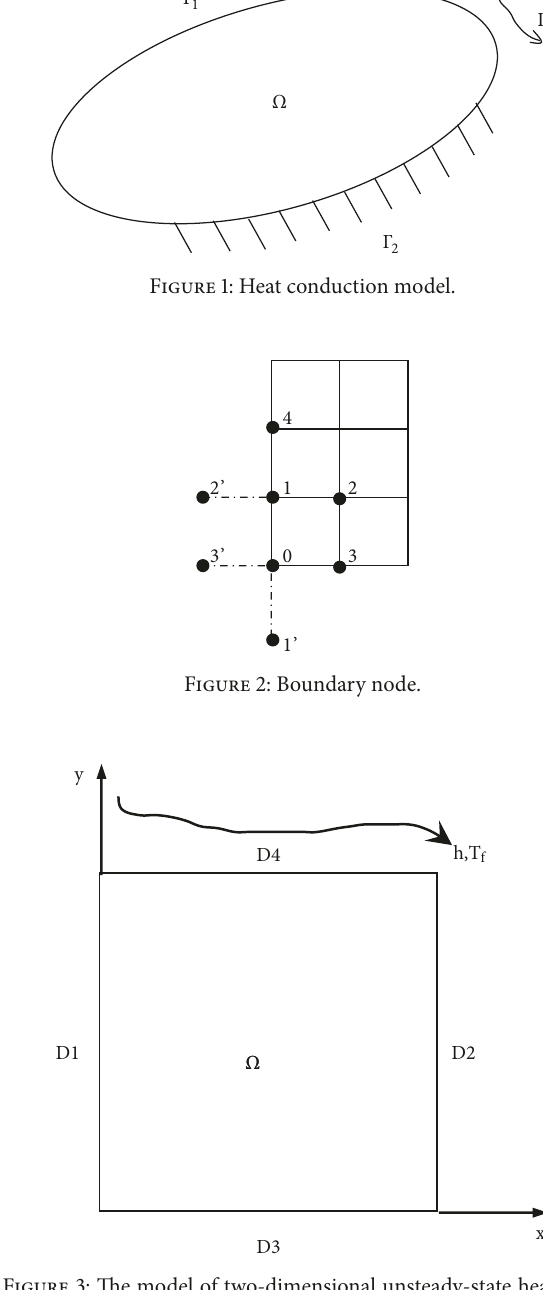
Figure 3: The model of two-dimensional unsteady-state heat con- duction system without internal heat